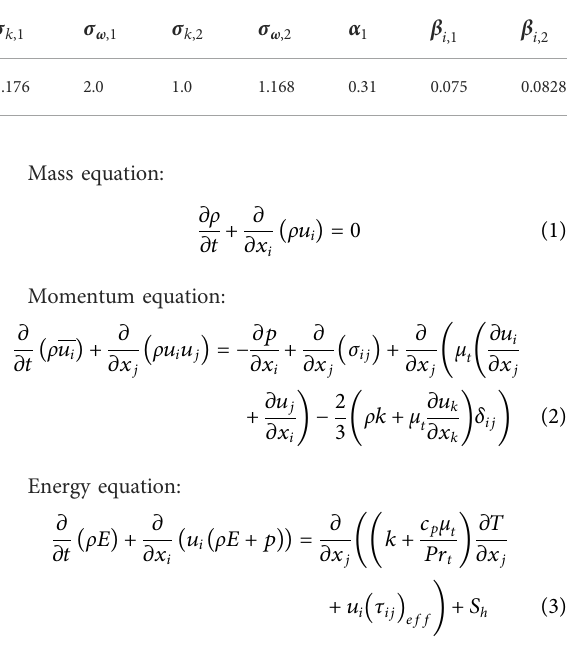
TABLE 2 Constants used in the turbulence models.